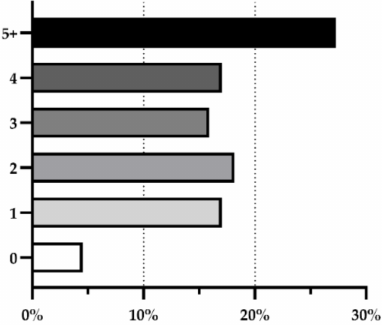
Figure 3. Prevalence of products for sensitive skin that contain no allergens (0), one allergen (1), or combinations of allergens (2; 3; 4;